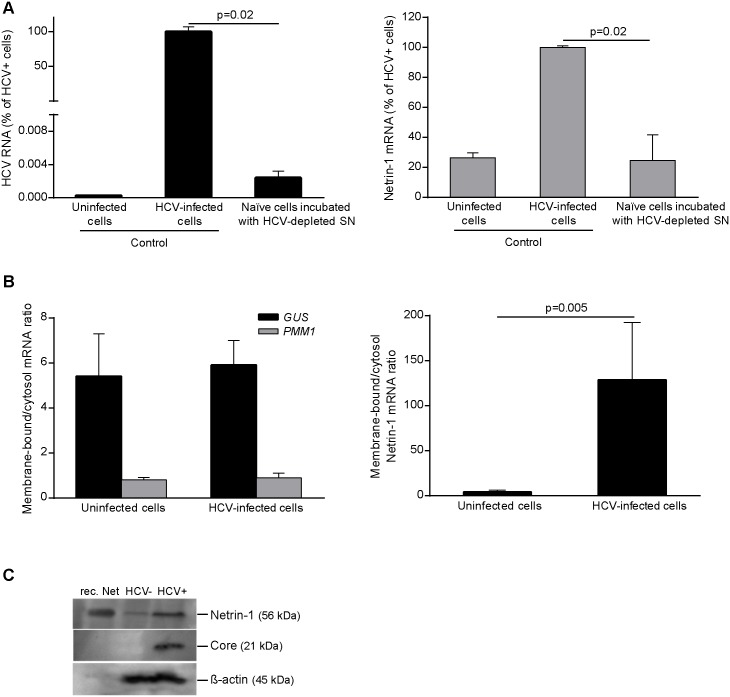
HCV increases Netrin-1 mRNA and protein.
A. Virions depletion experiment. Huh7.5 cells were infected by HCV over 3 d, and the supernatant (SN) was collected, depleted of HCV particles by ultracentrifugation, and added to naïve Huh7.5 cells. Levels of HCV RNA (left) and Netrin-1 mRNA (right) were quantified by RT-qPCR. Data are represented as mean ± standard deviation (n = 3). B. HCV increases the association of Netrin-1 mRNA with microsomes (endoplasmic reticulum [ER] membrane)-bound polysomes in Huh7.5 cells. Netrin-1, Glucuronidase (GUS), and phosphomannomutase 1 (PMM1) mRNA were monitored for their partitioning in the cytosolic (free polysomes) and microsome (ER membrane-bound polysomes) compartments according to the infection status of the cells through sequential extractions followed by RT-qPCR. Statistical significance was determined using the Mann-Whitney test, p < 0.05. C. Netrin-1 protein expression is increased in HCV-positive cells. The level of Netrin-1 protein was detected in microsomes in Huh7.5 cells, naïve and HCV infected cells by immunoblotting using 200 μg of protein, anti-Netrin-1 antibody and recombinant Netrin-1 (rec. Net) as a control. Infection (core signal) and loading control (β-actin signals) are shown. The underlying data for panels in this figure can be found in S1 Data.